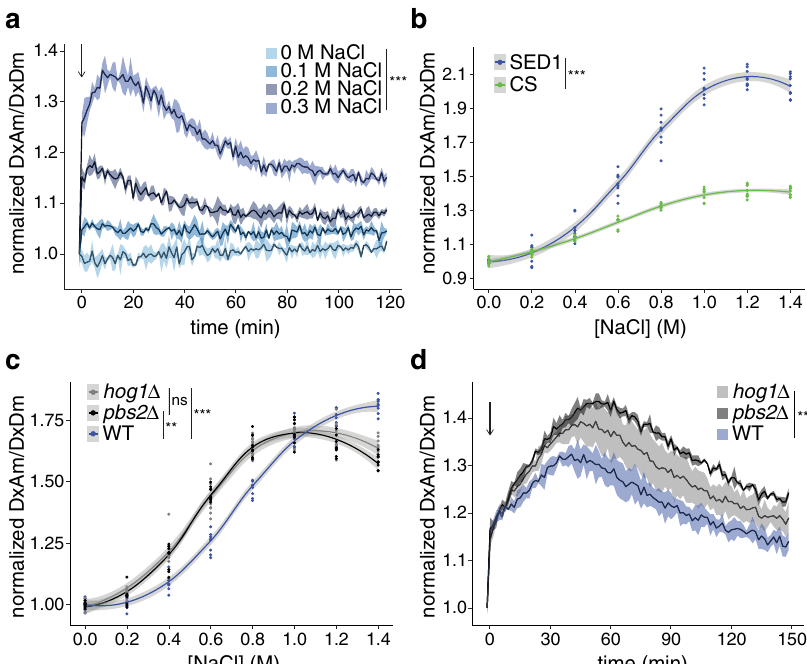
Fig. 3 SED1 can dynamically track the effects of osmotic stress on live yeast cells. a Normalized FRET ratio (DxAm/DxDm) time course of live yeast cells expressing SED1, treated with different concentrations of NaCl. The arrow indicates the addition of the treatment. Mean ± SEM. One-way ANOVA. *** p < 2 ×10 − 16 . b Normalized FRET ratio (DxAm/DxDm) of live yeast cells expressing SED1 (blue) and CS (green), treated with different concentrations of NaCl. One-way ANOVA. *** p < 2 ×10 − 16 . Continuous lines were smoothed using R with a loess smoothing function. Shaded regions indicate 95% con fi dence intervals. c Normalized FRET ratio (DxAm/DxDm) of wild type BY4742 strain (blue), hog1 Δ ::G418 mutant (gray), and pbs2 Δ ::G418 mutant (black), live yeast cells expressing SED1, hyperosmotically shocked with different concentrations of NaCl. Measurements were done immediately after hyperosmotic shock. Two-way ANOVA. * p < 0.05, ** p < 0.01, *** p < 0.001. Continuous lines were smoothed using R with a loess smoothing function. Shaded regions indicate 95% con fi dence intervals. d Normalized FRET ratio (DxAm/DxDm) time course of wild type BY4742 strain (blue), hog1 Δ ::G418 mutant (gray), and pbs2 Δ ::G418 mutant (black), live yeast cells expressing SED1, treated with 0.6 M sorbitol. The arrow indicates the addition of the treatment. Mean± SEM. Two-way ANOVA. *** p < 2 ×10 − 16 . Source data are provided as a Source Data fi